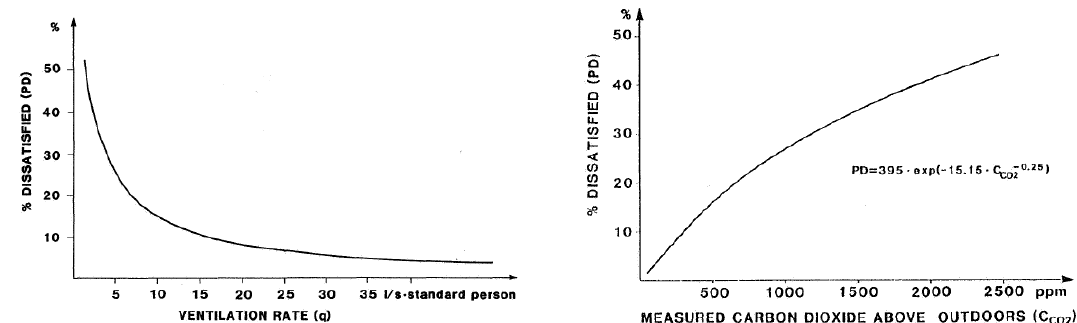
Figure 1. Ventilation rate vs. percentage dissatisfied occupants ( left ); measured CO 2 vs. percentage dissatisfied occupants ( right ) [6].